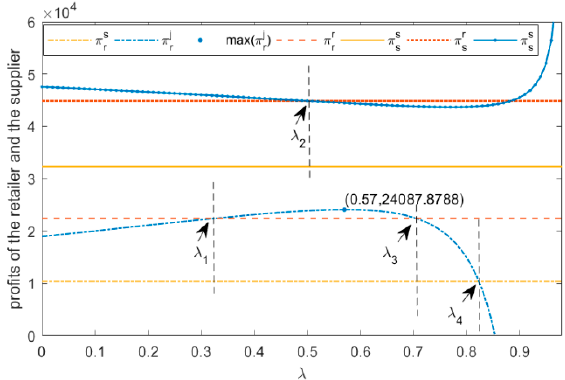
λ under three strategies. Figure 6. Profit of the retailer and supplier with respect to